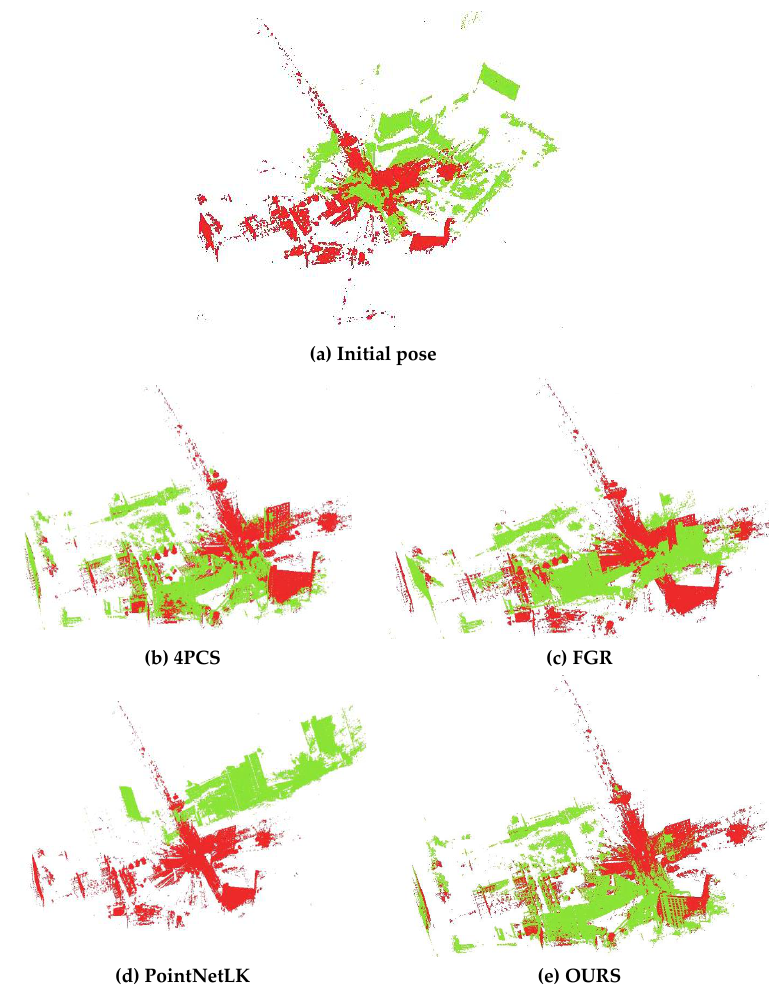
Figure 5. Registration results of each algorithm for campus scenes.